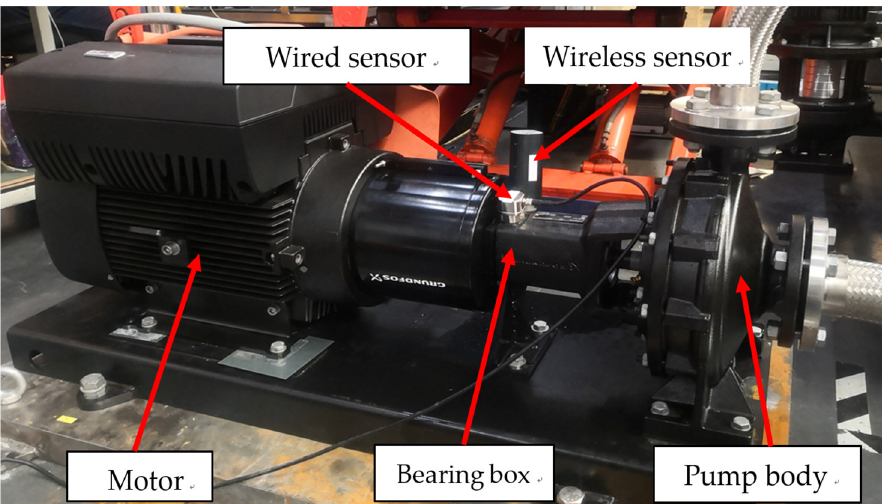
Figure 6. Experimental setup for fault diagnosis of the centrifugal pump.